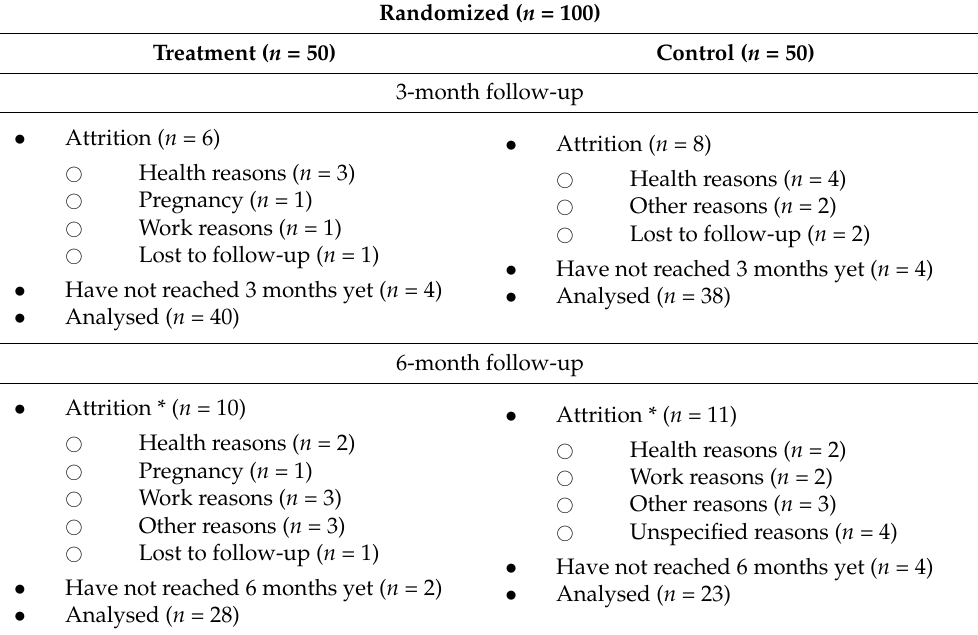
Table 1. Participant randomization, follow-up and attrition. Randomized ( n =